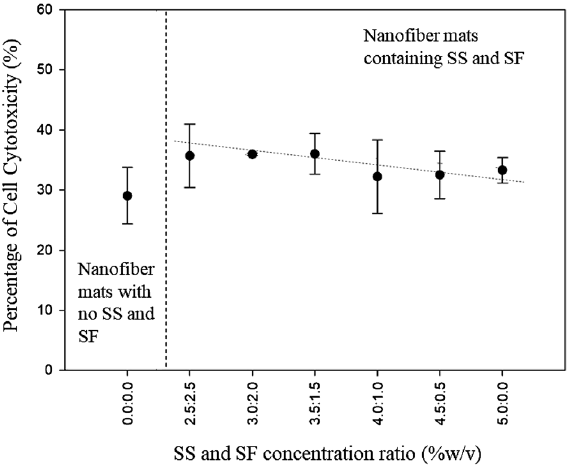
Figure 7. Cell cytotoxicity of the fabricated nanofiber mats with different SS/SF concentration